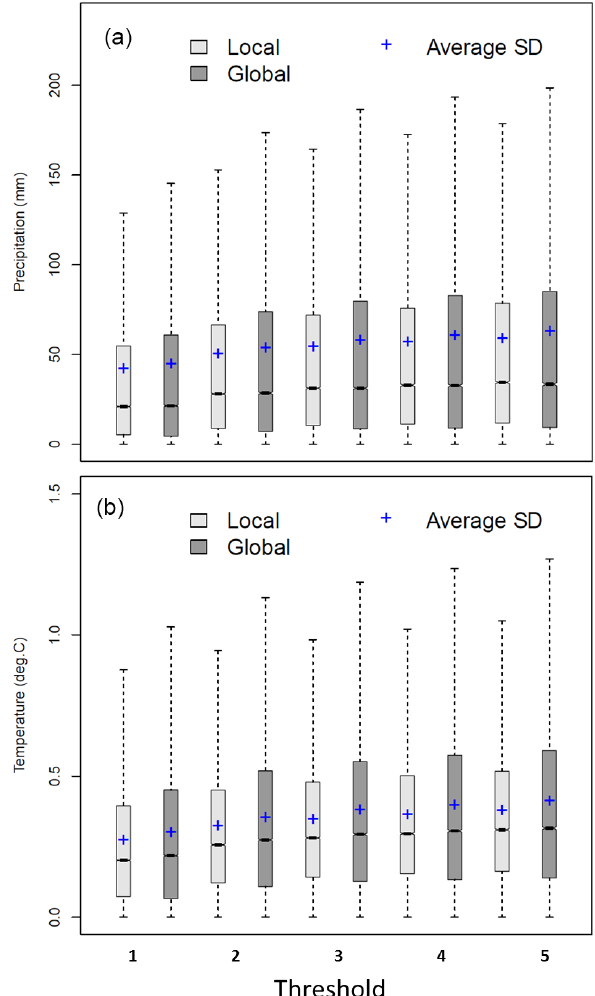
Figure 11. Similar to Fig. 5, but for the capability of the global and local methods to capture climatic variability based on SD of the PRISM 30-year normal precipitation (a) and surface tempera- ture (b) , within the non-geo-located SUs derived based on elevation, slope and aspect across different values of area